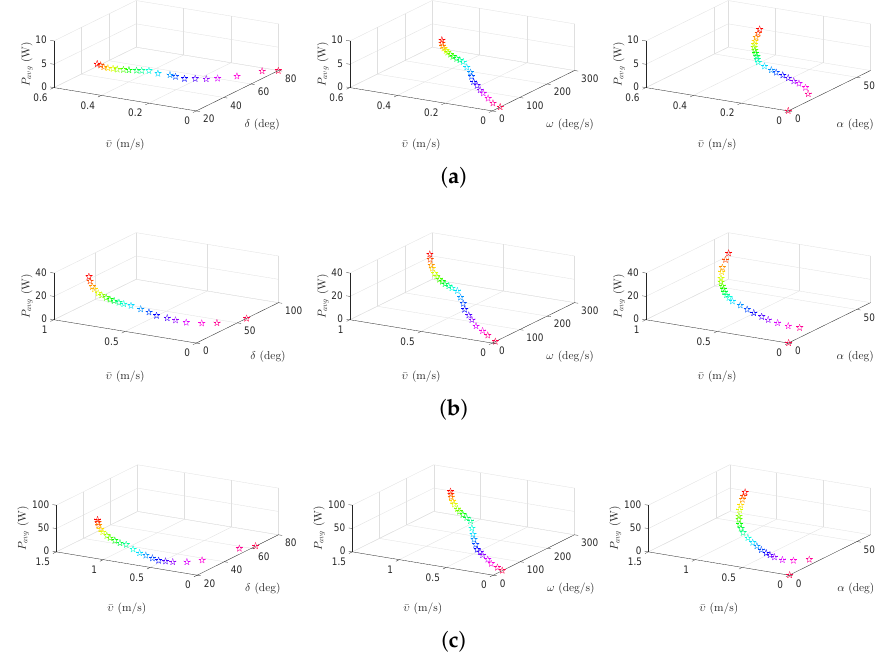
Figure 8. Optimal gait parameters for the lateral undulation motion pattern for the USR, without considering the negative work effect: ( a ) 3D plots of optimal gait parameters for robot with n = 5 links; ( b ) 3D plots of optimal gait parameters for robot with n = 10 links; and ( c ) 3D plots of optimal gait parameters for robot with n = 20 links. Colors illustrate different weights of the objective